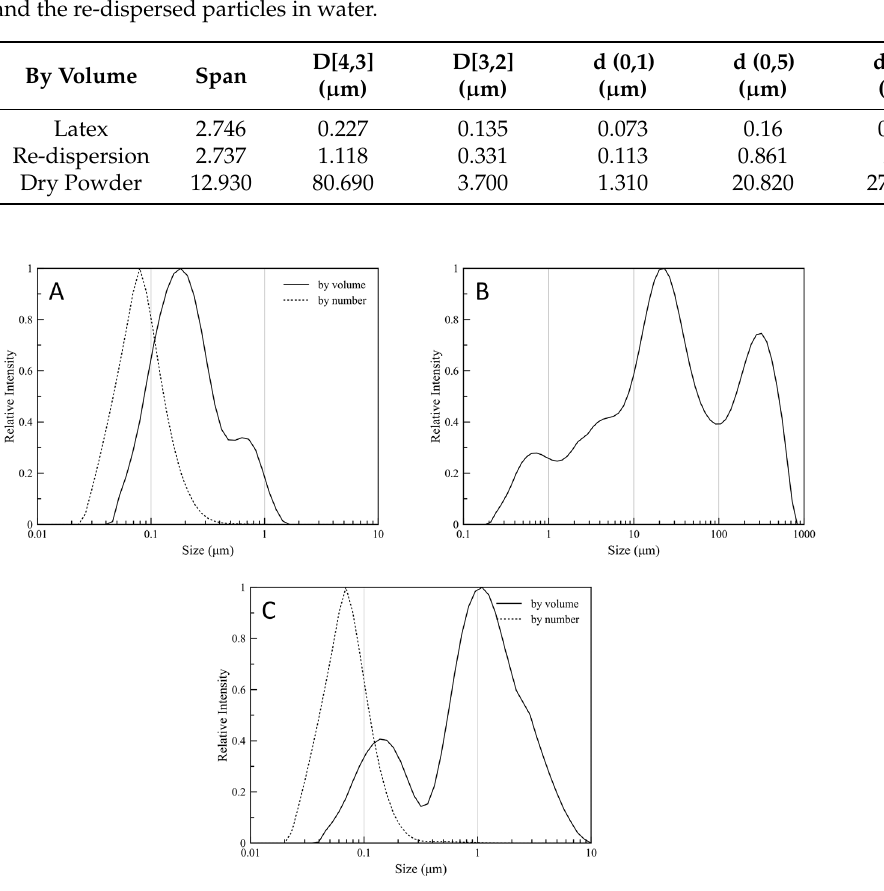
Figure 7. Particle size distribution for the synthesized ( A ) latex particles, ( B ) the dried particles, and ( C ) the re-dispersed particles in water.